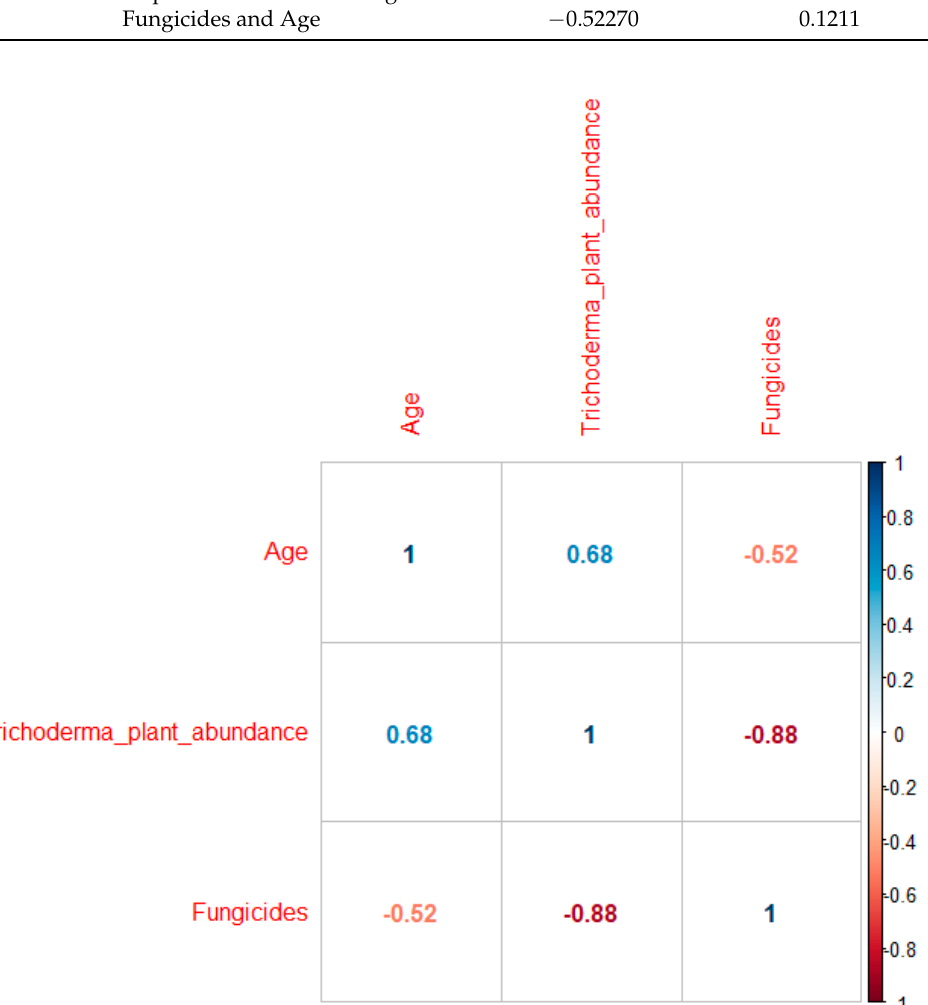
Figure 3. Correlation plot between variables Age, Fungicides, and Trichoderma plant abundance. Values closer to 1 refers a strong positive correlation. Values closer to − 1 refers a strong negative correlation.